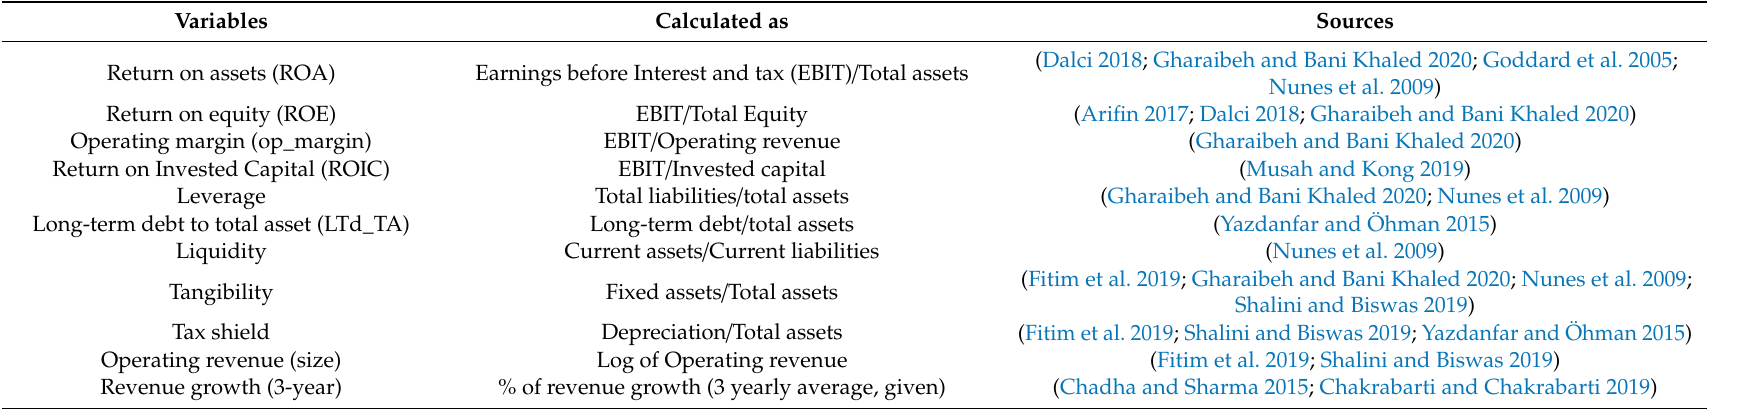
Table 2. List of dependent and explanatory variables.